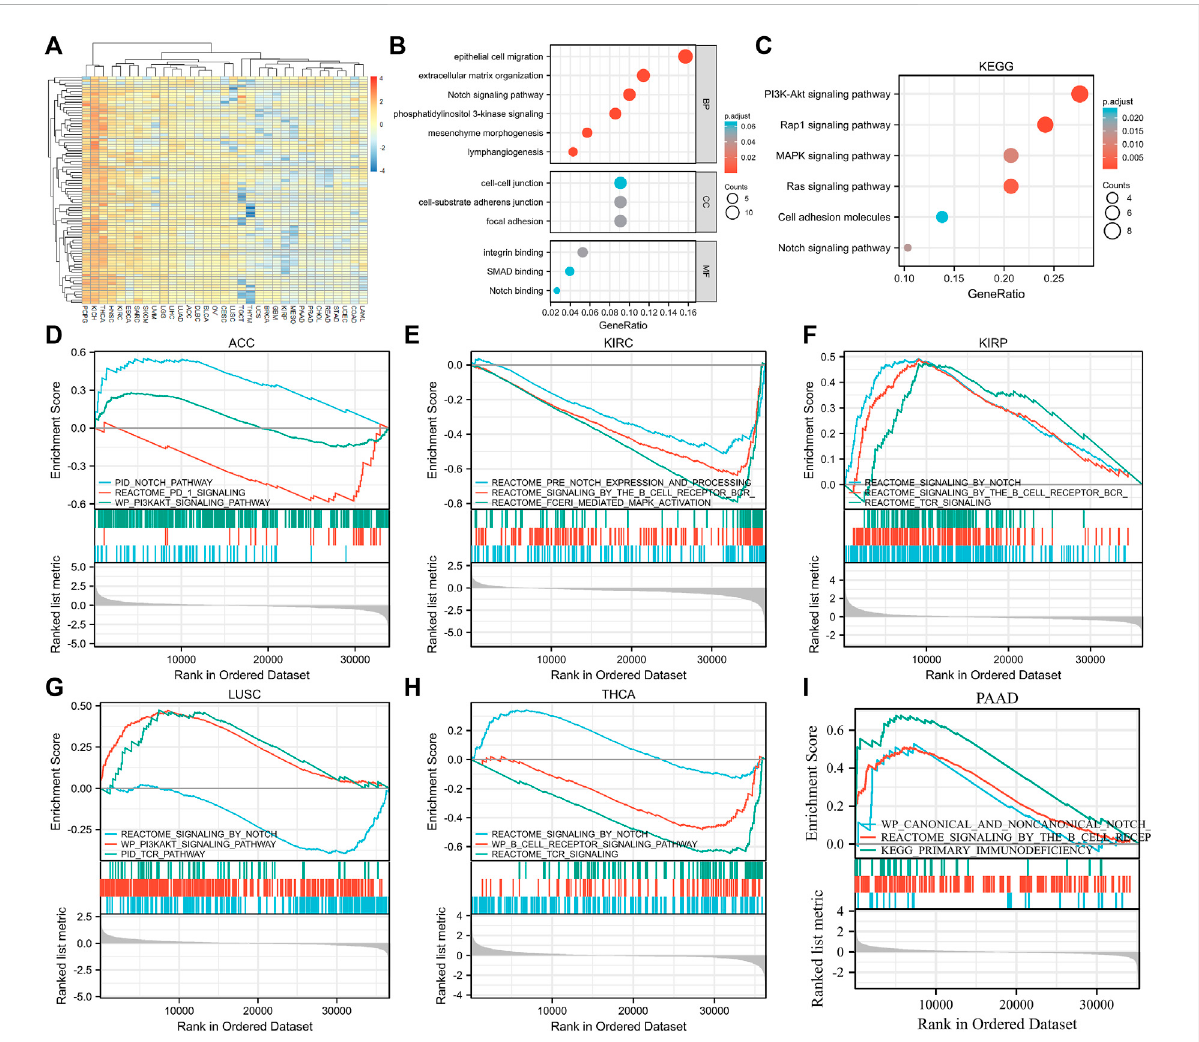
FIGURE 10 Functional enrichment analysis ofEXOC3L1-related genes. (A) Heatmap of EXOC3L1-related genes expression in33 tumors in TCGA database. (B) GO enrichment analysis based on 100 EXOC3L1-related genes, including BP, CC, and MF. (C) KEGG pathways analysis based on 100 EXOC3L1- related genes. (D – I) GSEA based on the differentially expression analysis in ACC, KIRC, KIRP, LUSC, THCA, and PAAD,